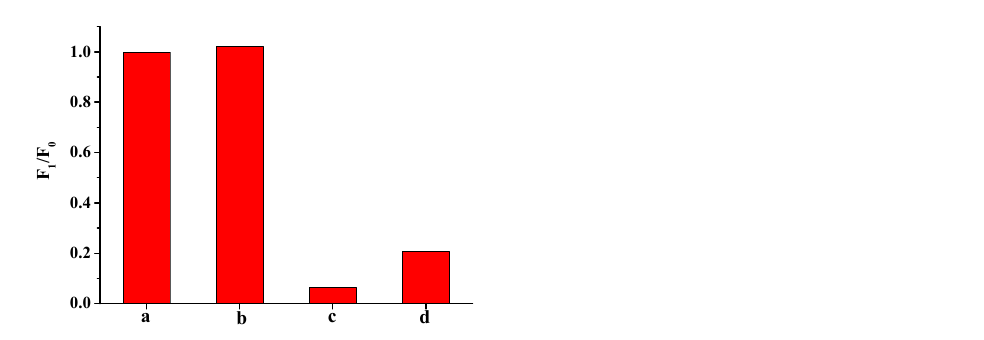
Figure 14. The circular dichroism spectra of ( a ) DNA2-Ag NCs and ( b ) DNA2-Ag NCs/Cu 2+ .